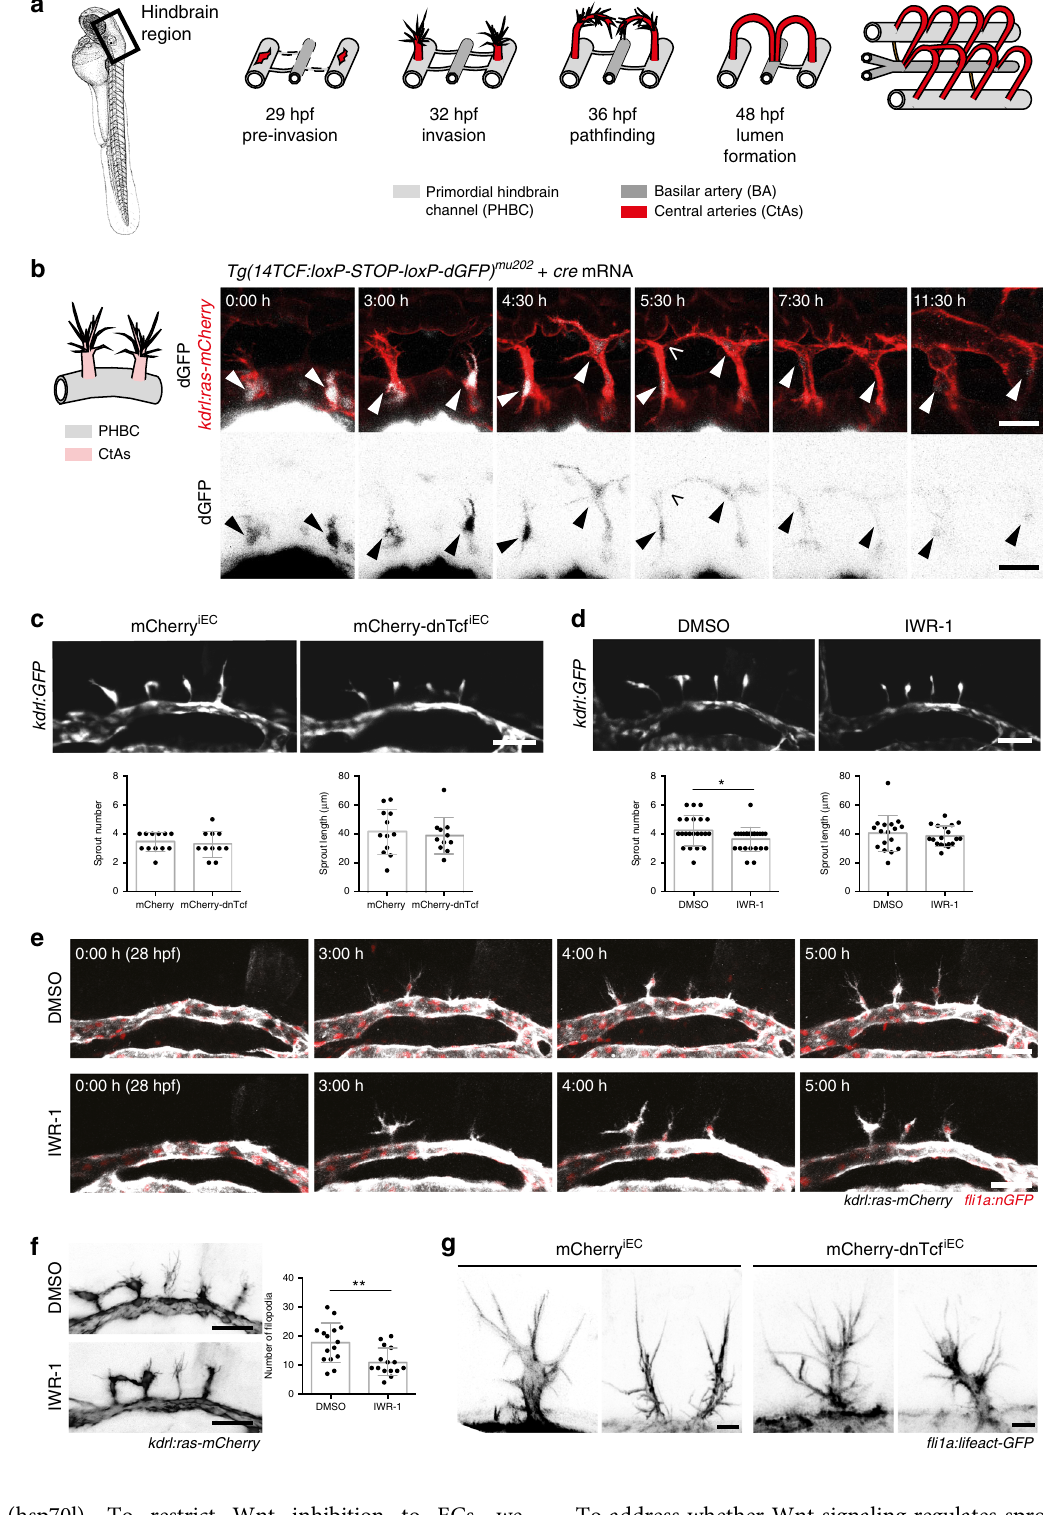
promoter (hsp70l). To restrict Wnt inhibition to ECs, we placed a loxP- fl anked ( fl oxed) STOP-cassette upstream of the mCherry-dnTcf coding sequence (Supplementary Fig. 2a, c). This STOP cassette was removed only in ECs by mating to fi sh with endothelial-speci fi c Cre recombinase expression ( Tg(kdrl: cre) s898 ). Validation of Wnt inhibition by heat shock controlled mCherry-dnTcf expression is documented in Supplementary Fig. 2.